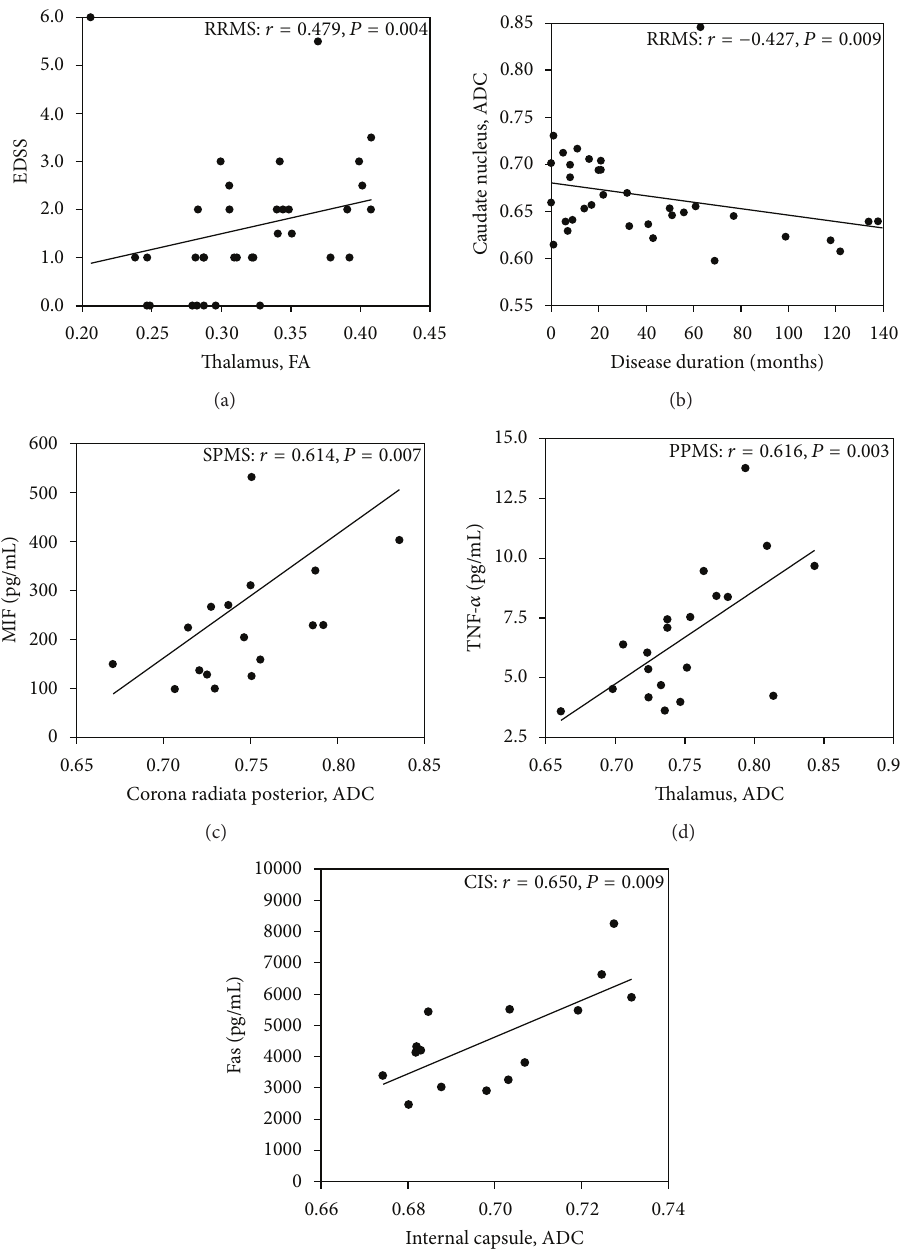
Figure 3: Correlations between DTI indices and clinical and immunological parameters in MS and CIS. Statistically significant correlations were found between the EDSS score and FA values for the thalamus in RRMS (a), disease duration and ADC values for the caudate nucleus in RRMS (b), the levels of MIF and the ADC values for the corona radiata posterior in SPMS (c), the levels of TNF- 𝛼 and the ADC values for the thalamus in PPMS (d), and the levels of Fas and the ADC values for the internal capsule in CIS